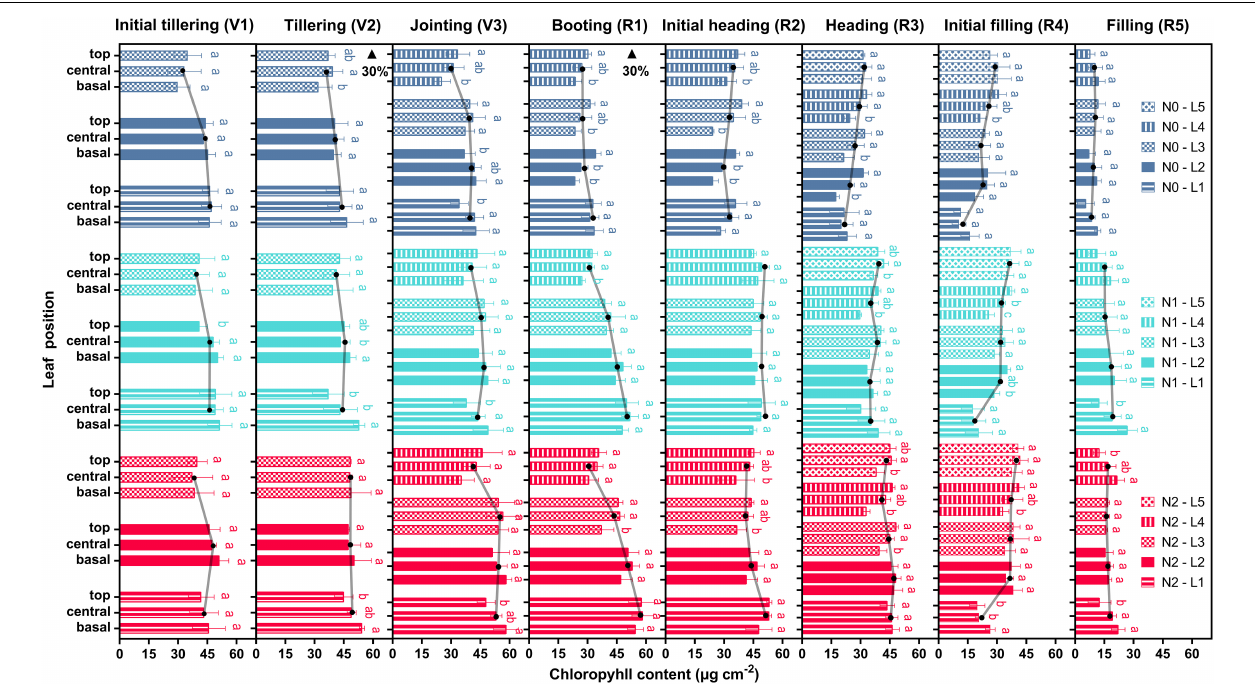
FIGURE 2 | Dynamics of leaf Chl content during different growth stages. The histogram shows the variations of the Chl content within a single leaf and the vertical distribution of the canopy (L1–L5). The solid lines with black dots are averages of basal, central, and top values. Error bars indicate the standard deviation (SD) of four replicates. Values within a leaf followed by the same letter are not significantly different ( P ≥ 0.05, Fisher’s LSD test). Black arrows denote the timing of topdressing of nitrogen